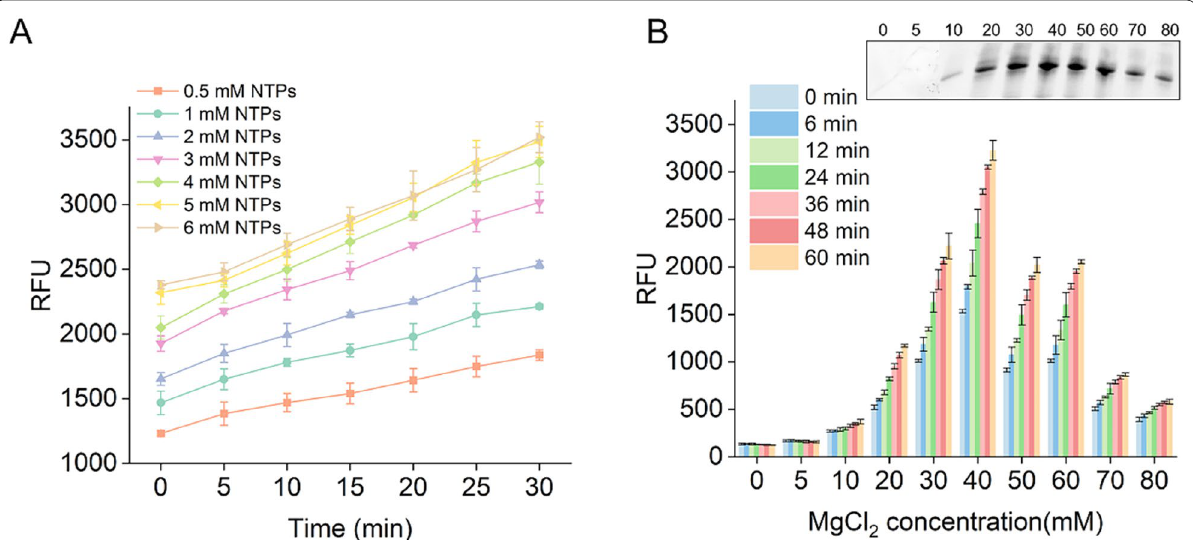
Fig. 3 Effects of ribonucleotide triphosphate and MgCl 2 concentrations on the STAR system. A Effect of NTP concentrations ranging from 0.5 mM to 6 mM. The relative fluorescent units were measured every 5 min. Error bars are standard errors of the mean (SEM). B Effect of MgCl 2 concentrations ranging from 5 to 80 mM. The relative fluorescent units were measured every 6 min. The inset shows the results of denaturing PAGE analysis of the 60‑min transcription products under different MgCl 2 concentrations. Error bars represent the standard deviation of the triplicate